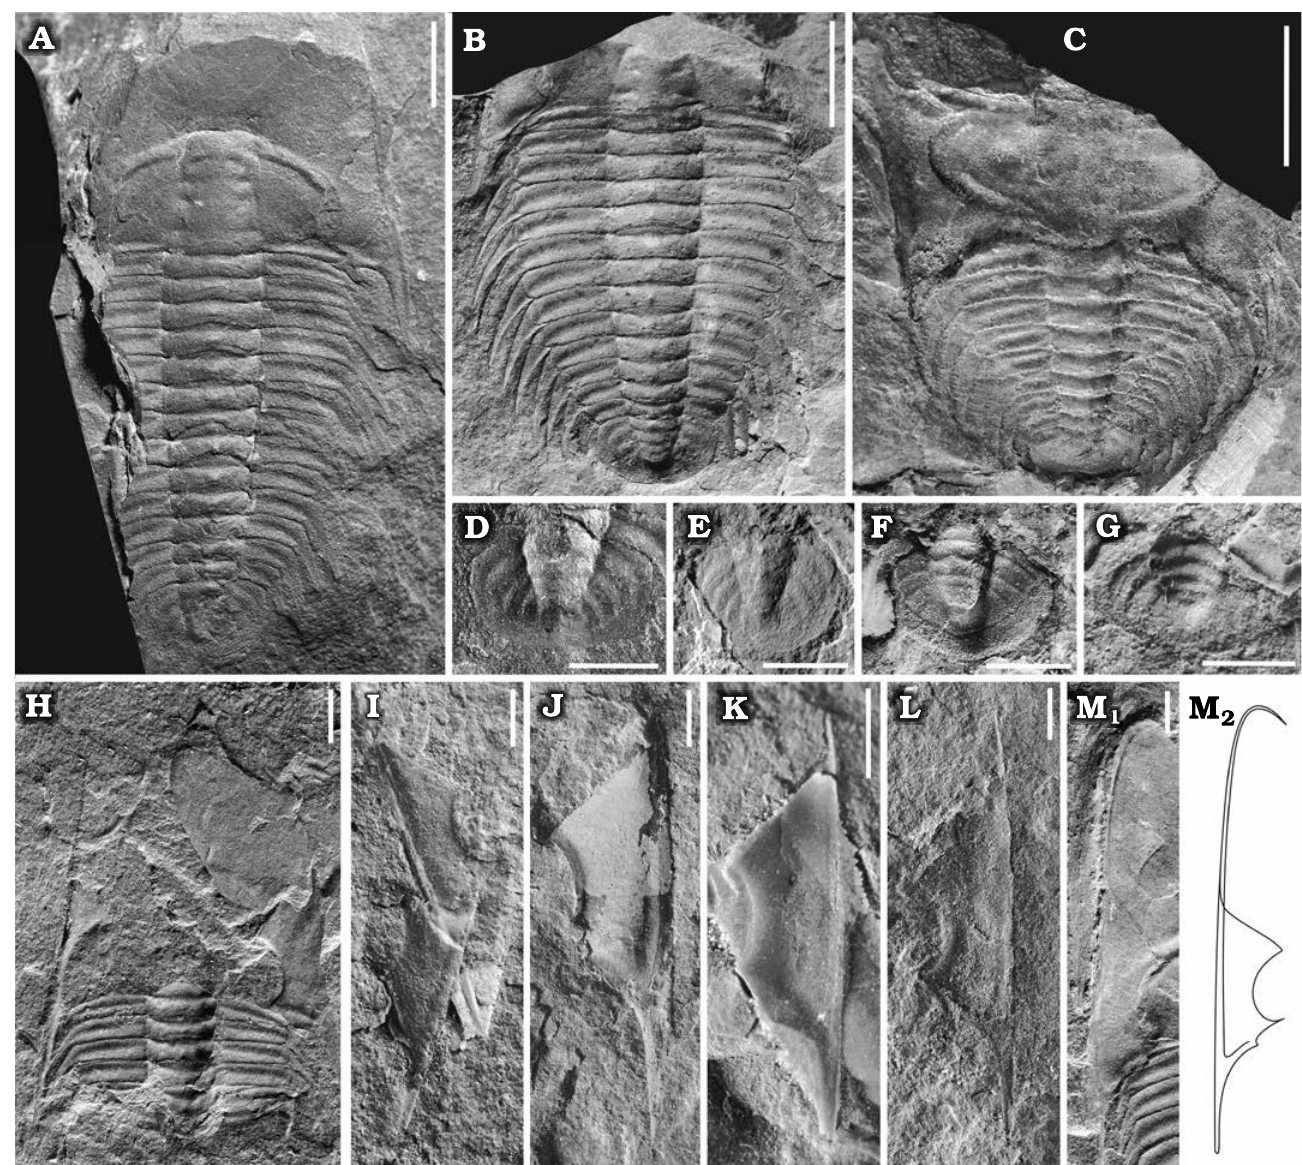
Fig. 5. A ptychoparioid trilobite Phantaspis auritus gen. et sp. nov. from the middle Cambrian (Miaolingian, Wuliuan) Mantou Formation, Longgang section, Shandong Province, North China. A . NIGPAS 172126 (paratype), nearly complete exoskeleton. B . NIGPAS 172127 (paratype), incomplete exoskeleton. C . NIGPAS 172128 (paratype), nearly complete exoskeleton showing enrollment. D – G . Pygidium, NIGPAS 172129. 172130, 172115, 172131, respectively. H . NIGPAS 172132, moult assemblage consisting of a disarticulated cranidium, librigenae, and thoracic segments. I – M . Librigenae, NIGPAS 172133, 172134, 172135, 172136, 172104, respectively; M 2 , reconstruction of the librigena in M 1 . Scale bars A–C, 5 mm; D–M, 2